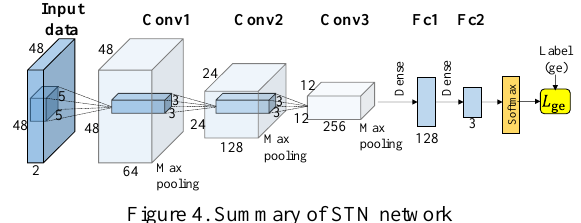
Figure 4. Summary of STN network